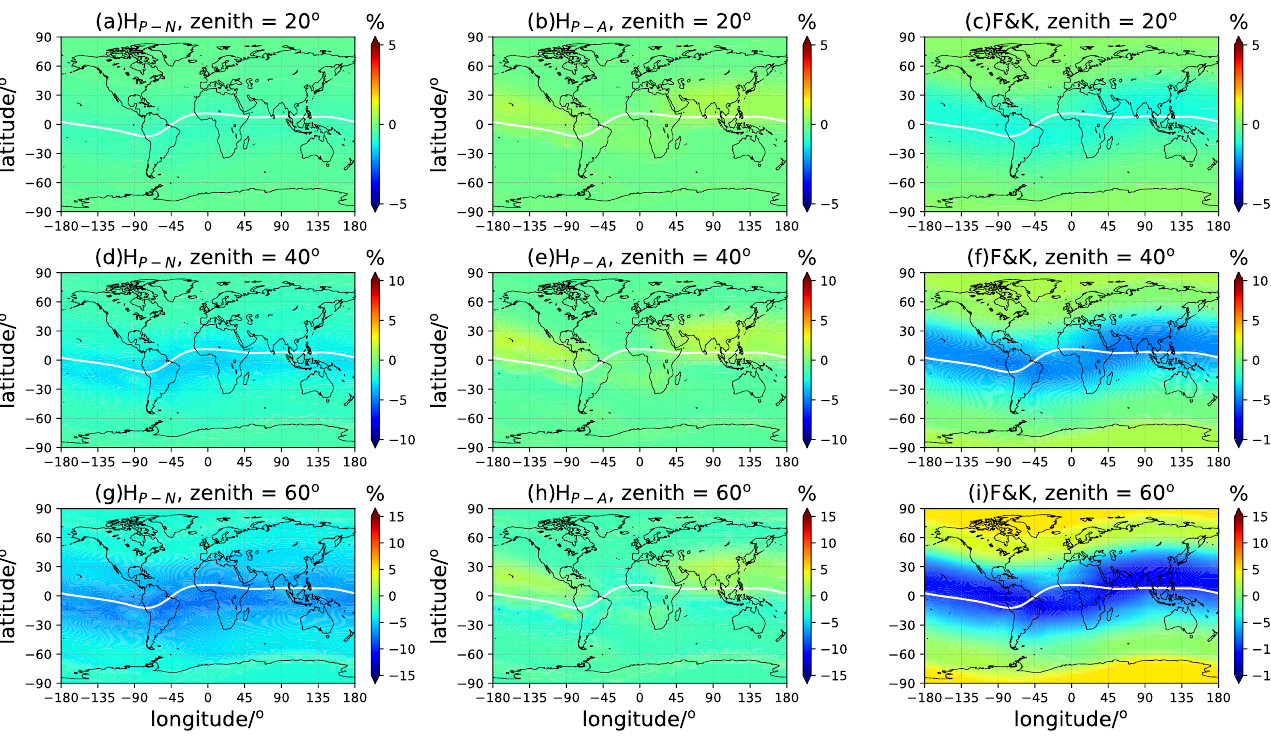
Figure 8. The longitude- and latitude-dependent variations of the retrieved VTEC mean deviation in the December solstice in LSA years. The zenith angle is chosen at 20° (panels ( a ), ( b ), and ( c )), 40° (panels ( d ), ( e ), and ( f )), and 60° (panels ( g ), ( h ), and ( i )), respectively. The ‘ 𝐻 𝑃_𝑁 ’, ‘ 𝐻 𝑃_𝐴 ’ , and ‘F&K’ represent the numerical and analytical mapping functions and the F&K model, respectively.